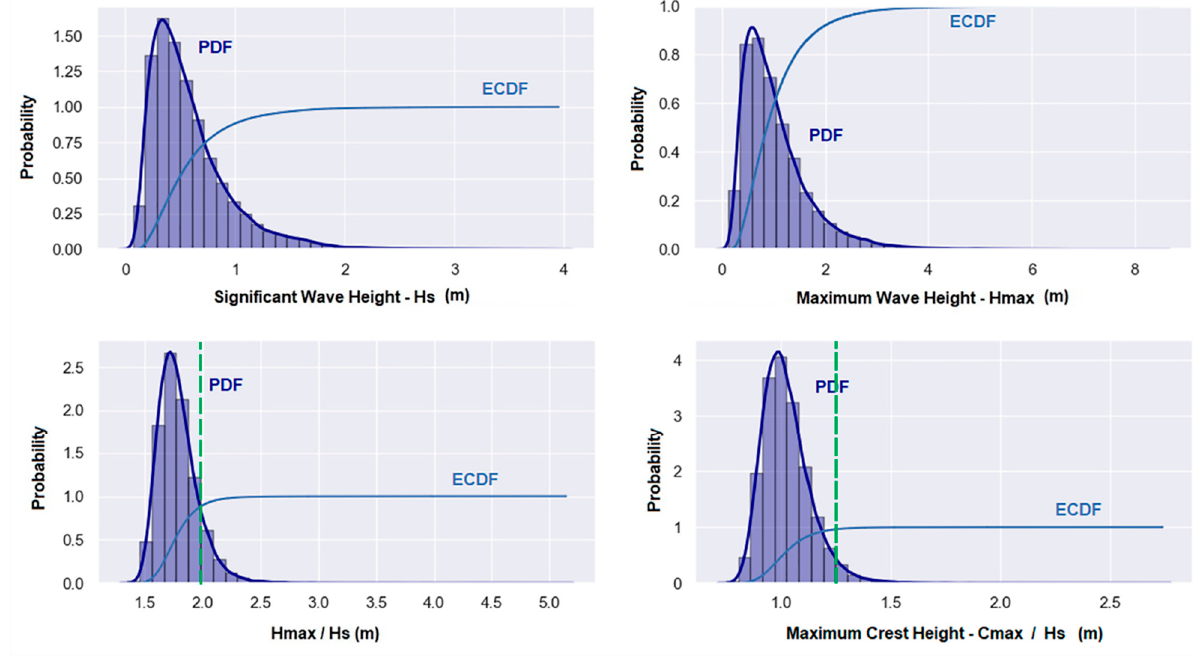
Figure 8. The probability density function and empirical cumulative density function of H s , H max , H max /H s (with the rogue wave threshold value of 2 marked by the green dashed line) and C max /H s (with the rogue wave threshold value of 1.25 marked by the green dashed line).